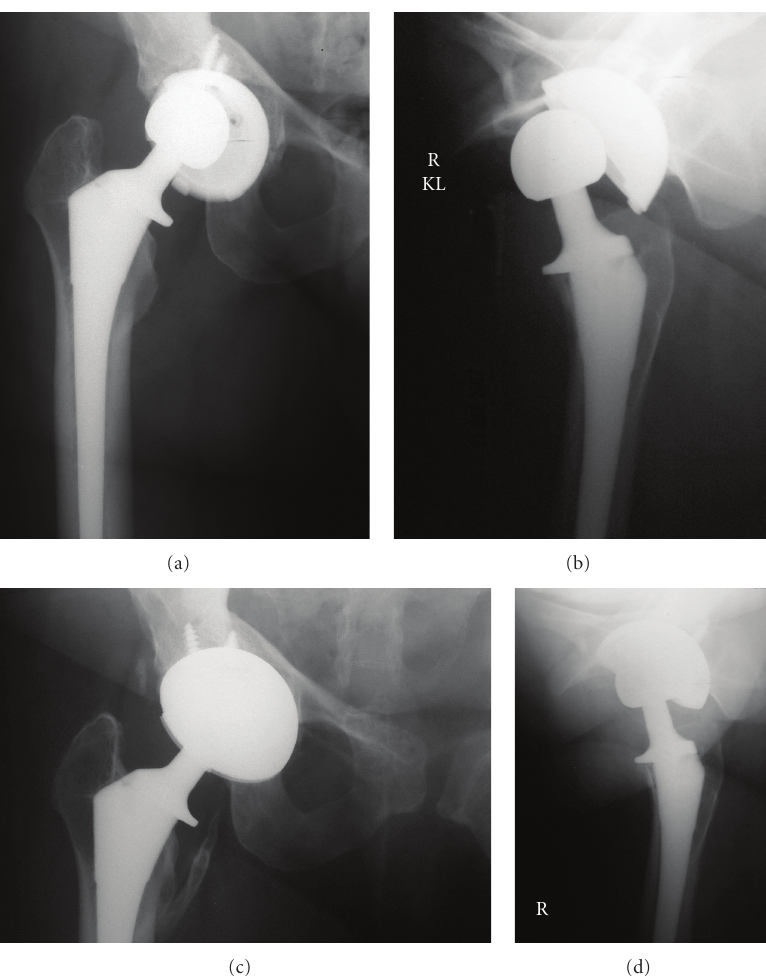
Figure 1: (a) Patient 1: anteroposterior radiographs demonstrating eccentric placement of the femoral head within the acetabular polyethylene and excessive acetabular component abduction. (b) Patient 1: direct lateral radiograph demonstrating anterior femoral head subluxation and excessive acetabular component anteversion. (c) Patient 1: anteroposterior radiographs demonstrating concentric femoral head positioning and corrected acetabular component abduction. (d) Patient 1: direct lateral radiograph demonstrating concentric femoral head positioning and corrected acetabular component